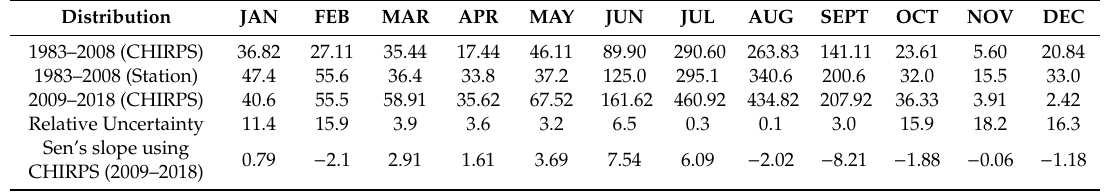
Table 9. Monthly distribution, trends, and uncertainty (mm / decade, 1983 to